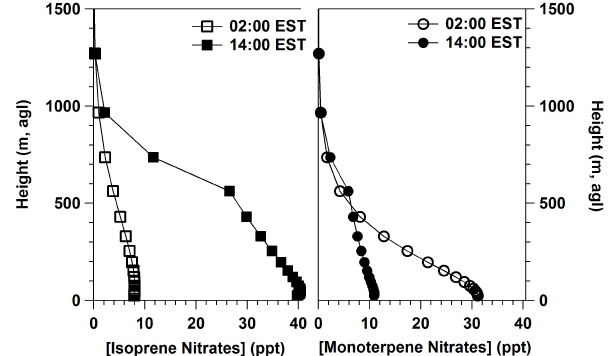
Fig. 4. Vertical profiles of total (primary and secondary) isoprene (left) and monoterpene (right) nitrate concentrations above the for- est canopy at 02:00 and 14:00EST. Total isoprene nitrates includes nitrates formed from first generation isoprene oxidation products (methacrolein, methyl vinyl ketone, and C 5 -unsaturated hydroxy- aldehyde isomers). The base and maximum emission rate scenarios are shown for the isoprene nitrates and monoterpene nitrates, re- spectively.